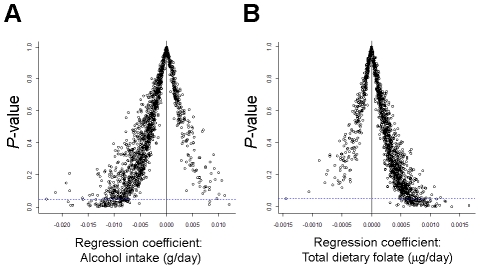
There is an opposite trend for direction of association between breast carcinoma CpG methylation and alcohol intake compared to folate intake.
P-values for alcohol intake (g/day) and total dietary folate (µg/day) are plotted versus regression coefficients from locus-by-locus analysis of CpG methylation. Horizontal blue dotted line intercepts the y-axis at 0.05 to illustrate significance (before correction for multiple comparisons). The vertical solid black like intercepts the x-axis at zero to illustrate the contrasting trends. (A) There is a trend toward decreased methylation with increasing alcohol intake. (B) There is a trend toward increased methylation with increasing dietary folate.